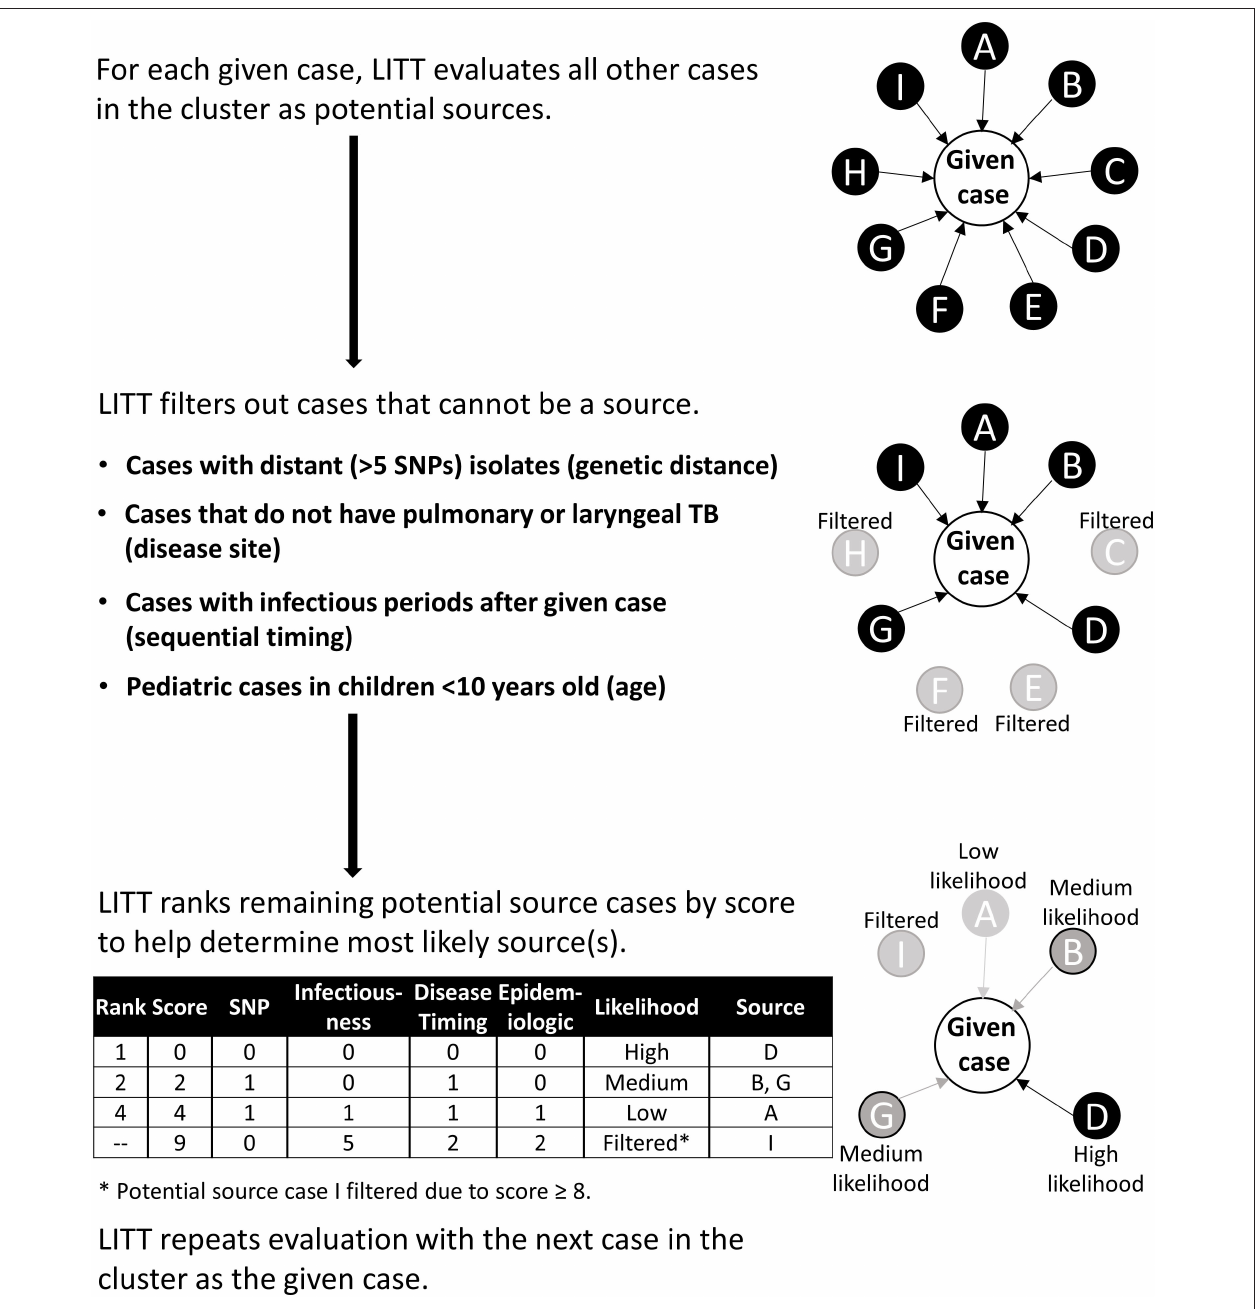
FIGURE 1 | Schematic overview of Logically Inferred Tuberculosis Transmission (LITT) algorithm. LITT picks one case to be the given case then looks at all other possible source cases in the cluster (cases A–I). First, LITT filters out cases that could not be a source (cases C, E, F, and H) based on genetic distance between isolates (i.e., distance in single nucleotide polymorphisms, or SNPs), a non-infectious disease site (i.e., extrapulmonary disease), sequential timing (i.e., cases with infectious periods after given case), and young age (i.e., typically non-infectious). Next, LITT scores the remaining cases and ranks these cases as potential sources by numeric score ( Table 1 , Appendix 1 in Supplementary Material ). LITT then repeats this process for each given case in the